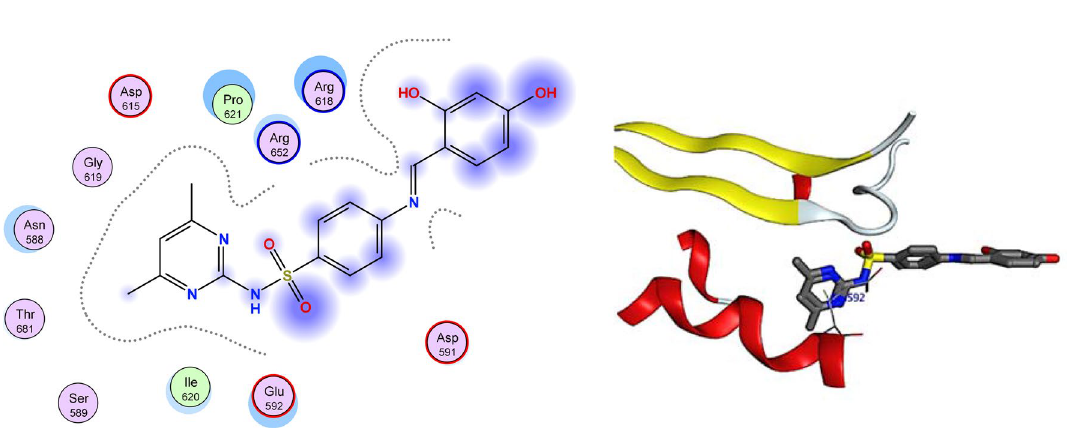
Figure 4. The 2D and 3D binding modes of 6e in the active site of DNA gyrase. H-bonds are represented by blue dashed